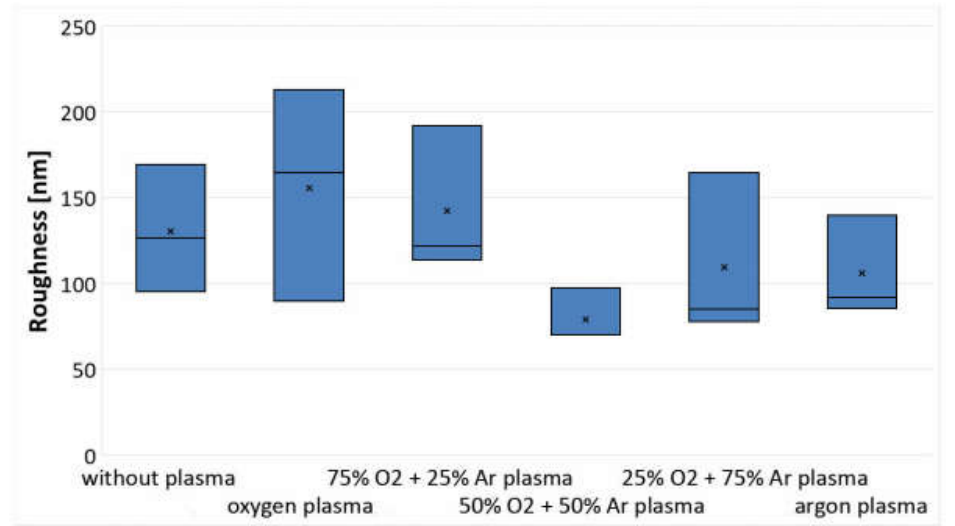
Figure 2. Values of roughness of PLA film, unmodified and plasma modified, using different gas compositions (box plot chart for 3 measurements, where box height shows maximum, minimum and median).